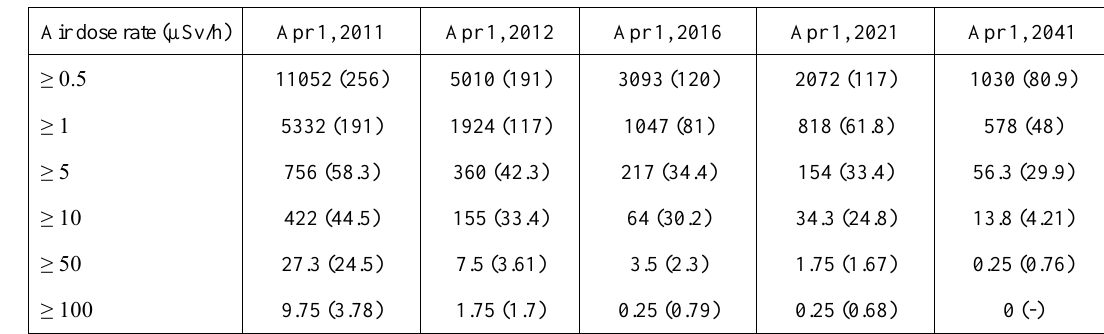
Table 1. The area (km 2 ) above each radiation intensity level. The maximum distance (km) from the Fukushima Daiichi NPP is in the prances.